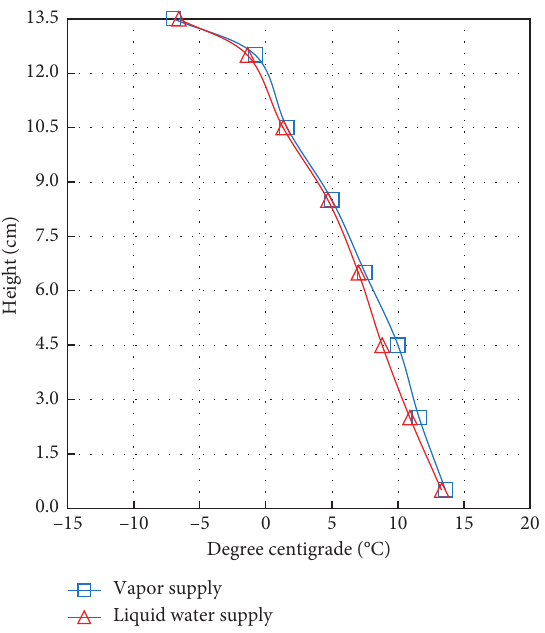
Figure 5: Measured temperature distribution of different water supply method. Figure 6. The increased water mass in five days is 106.1 g for the vapor supply method, which accounts for 66.7% of the